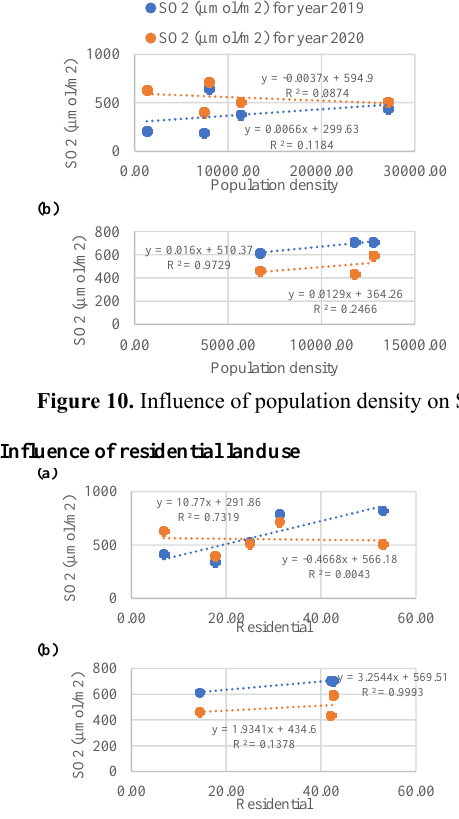
Figure 11. Influence of residential landuse on SO